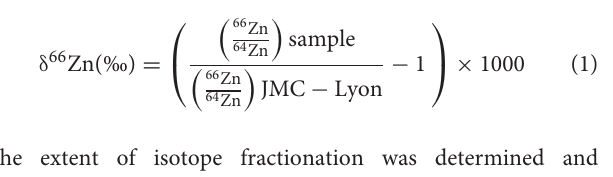
last step, 6 mL of 0.01N HCl was added to elute Zn from